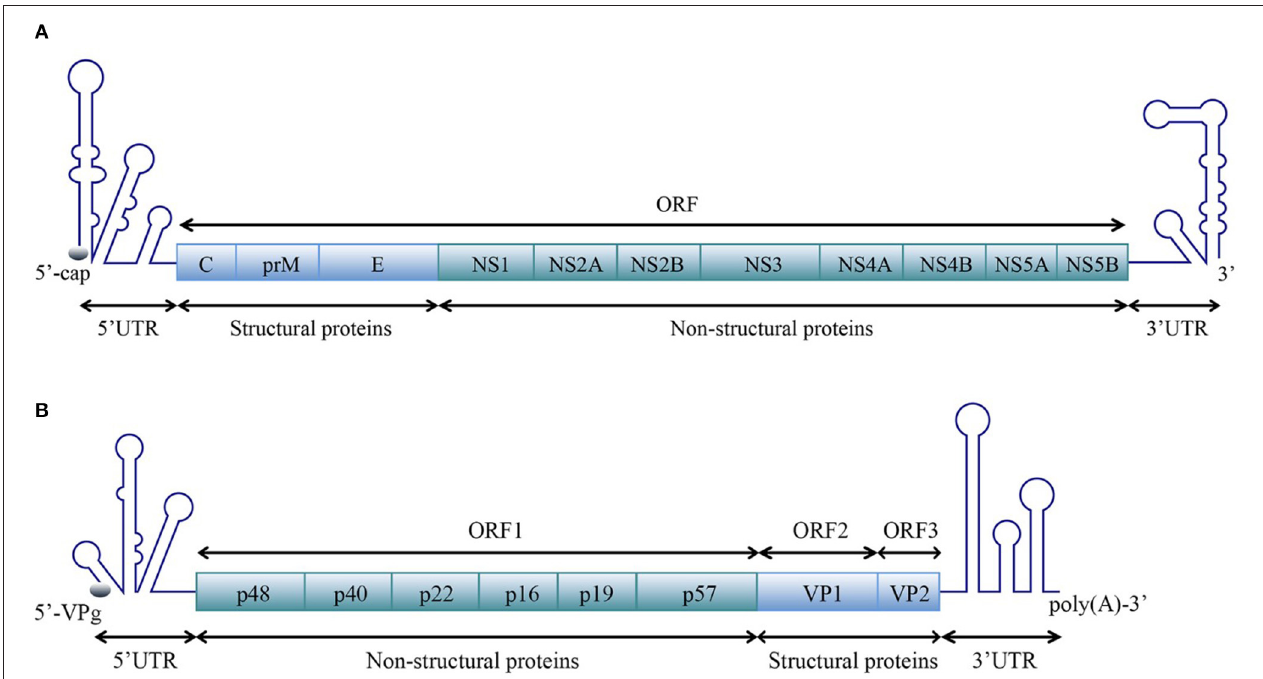
FIGURE 1 | Schematic representation of the organization of the ssRNA( + ) virus genome. A typical ssRNA( + ) virus genomic RNA is comprised of a 5 ′ UTR, ORF(s), and a 3 ′ UTR. (A) Viral genome with one open reading frame (ORF), using the example of WNV in the Flaviviridae family [reviewed in Suthar et al. (2013)]. (B) Viral genome with three ORFs, using the example of norovirus (NV) in the Caliciviridae family [reviewed in Thorne and Goodfellow (2014)]. The diagrams do not represent the true genomic length and